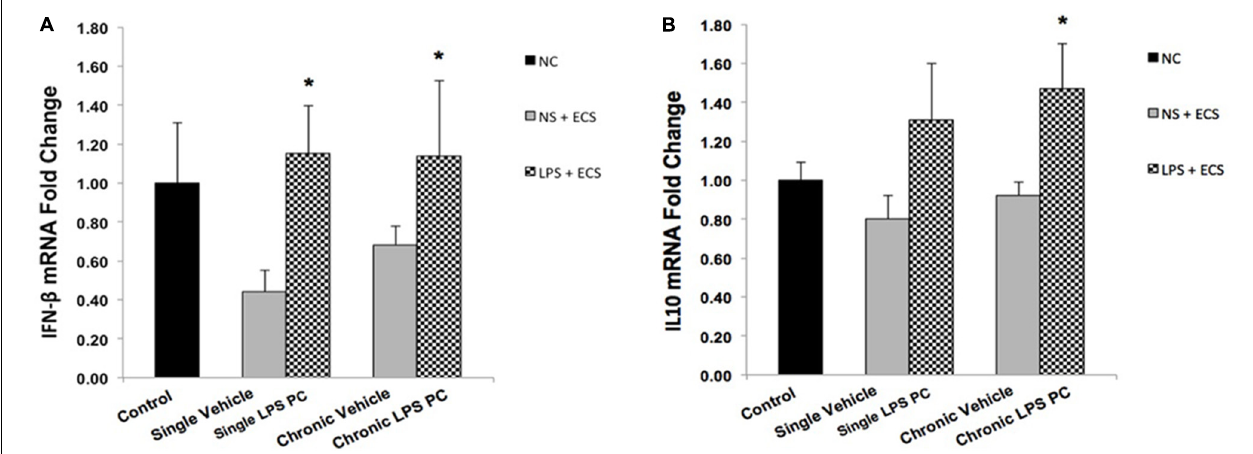
FIGURE 8 | Gene expression level of IFN- β and IL10 in the hippocampus region of rat brain in the ECS model of epilepsy. The graphs above display the effect of preconditioning by single low dose and chronic ultra-low dose of LPS on the gene expression level of (A) IFN- β and (B) IL10 in hippocampus in control, single preconditioned, and chronic preconditioned groups. Asterisk ( ∗ ) denotes a significant difference between the preconditioned groups and vehicle groups. Statistical analysis has been done according to the one-way ANOVA with significance levels of ∗ ρ < 0.05. Data are shown as mean ± SEM of three animals ( n = 3), which expressed as fold change relative to control group. ECS, electroconvulsive shock; NS, normal saline; LPS, lipopolysaccharide; PC, preconditioning; NC, no current was passed through the electrodes.